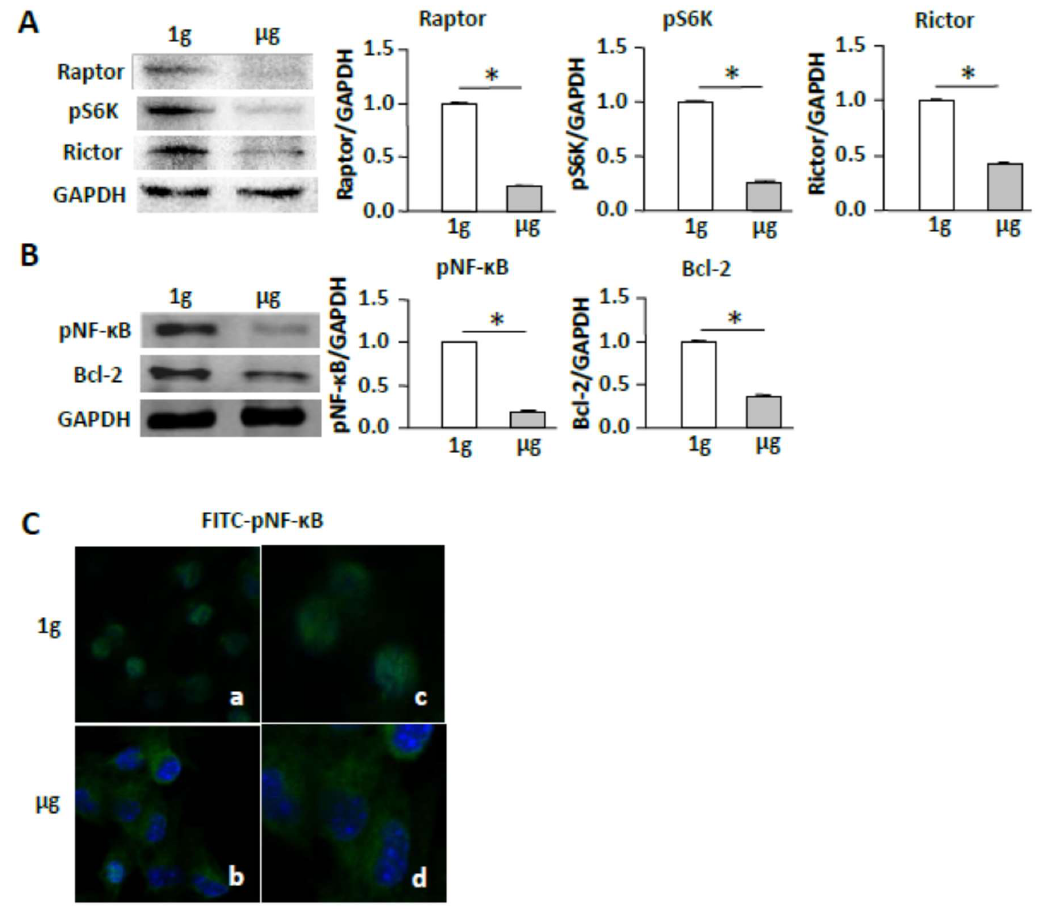
Figure 4. Simulated microgravity suppresses the mTORC/NF-κB pathway. ( A , B ) Lysates prepared from BL6-10 cells cultured for two days at 1 g or µg were subjected to SDS-PAGE analysis. Proteins were transferred onto PVDF membranes and blotted with indicated antibodies. Western blot band signals were quantified by chemiluminescence. Densitometric values were normalized to matching GAPDH controls. Data represent the me an ± SD of three independent experiments; ( C ) BL6-10 cells cultured for three days at 1 g or µg in a Lab-Tek1 II Chamber Slide TM System were fixed with paraformaldehyde, and subsequently incubated with anti-p-NF-κB (S337) (green) antibody and then incubated with FITC-labeled goat-anti-rabbit secondary antibody. Slides were covered using Prolong Gold Antifade Reagent with DAPI (blue) and observed by confocal microscopy. Panels ( a , b ) using 20× magnification; panels ( c , d ) using 50× magnification. * p < 0.05 versus different groups. One representative experiment of three is shown.